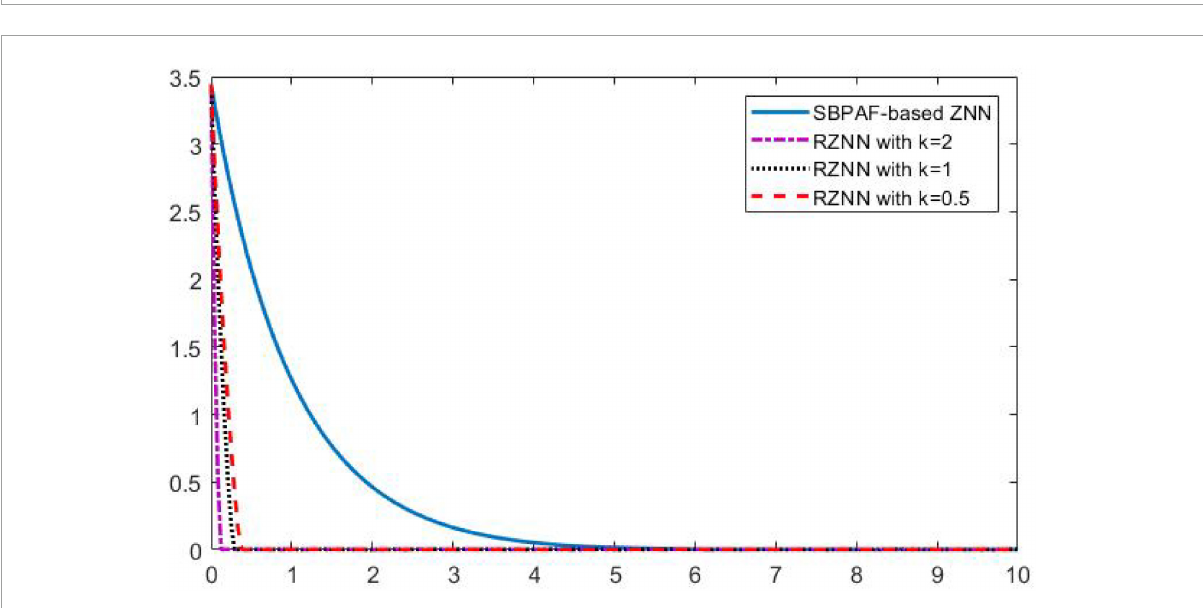
FIGURE5 Residual errors of robust zeroing neural network (RZNN) model (10) and sign-bi-power activation function (SBPAF)-based ZNN model (8) in no noise